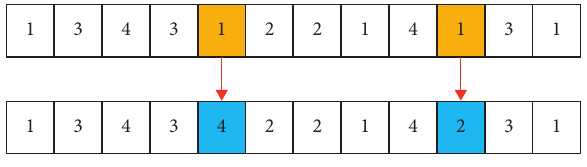
Figure 4: Modification of the operation